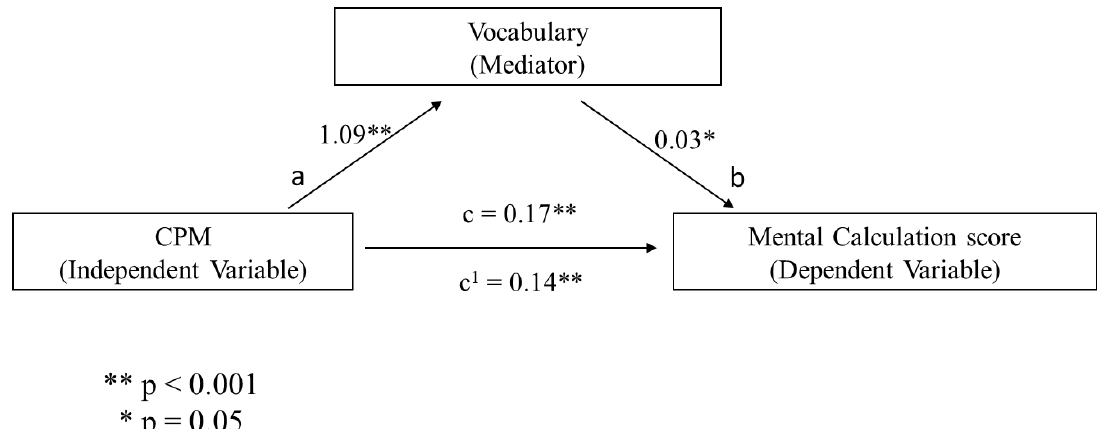
Figure 1. The predicted mediational pattern for Mental Calculation using CPM as the independent variable and educational attainment as mediator.